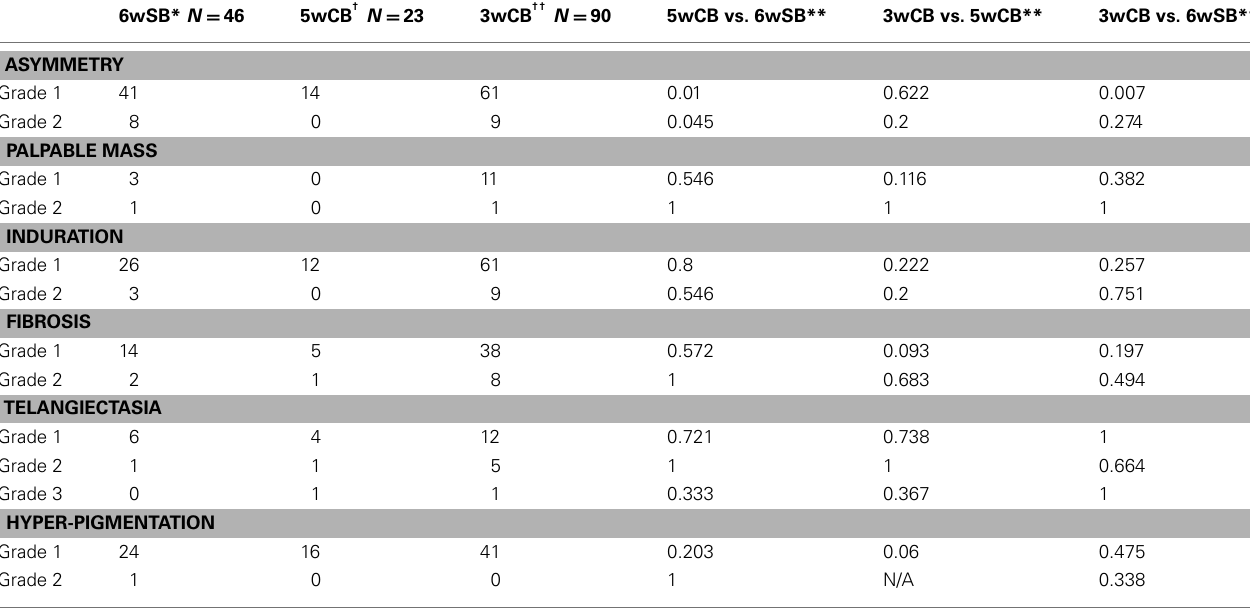
Table 5 | Comparison of late toxicity among the three regimens, at 5-year median follow-up ( N = 159